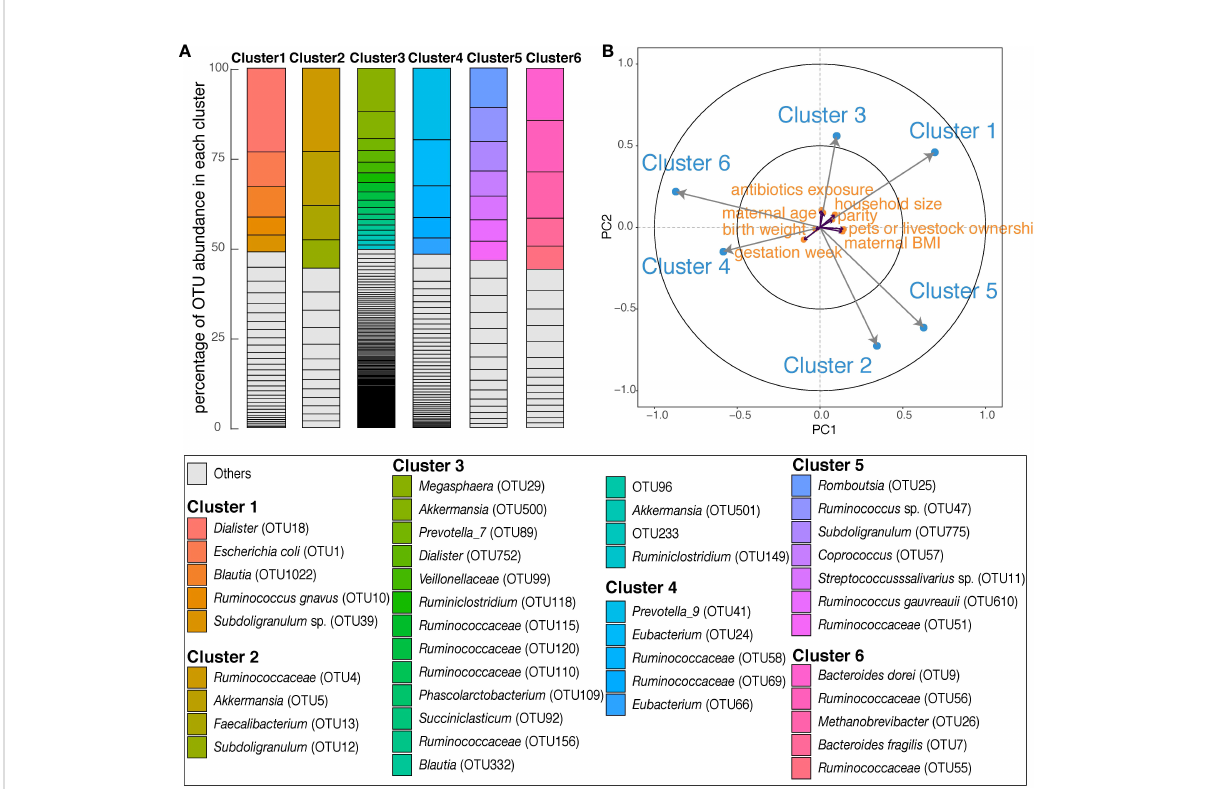
FIGURE 3 Overall description of six OTU clusters in maternal gut during late pregnancy. (A) Each column shows the OTU composition of each cluster. Within each column, OTUs are ordered according to the percentage of their relative abundance in each cluster. The identi fi cations of OTUs on species/genus level are listed in the box below; ‘ Others ’ are in Table S3. (B) The partial least squares biplot shows the associations between OTU clusters (blue) and covariates (orange). The longer the arrow the stronger the association with other variables. An acute angle between arrows represents positive association, an obtuse angle represents negative association and orthogonal arrows represent no association.